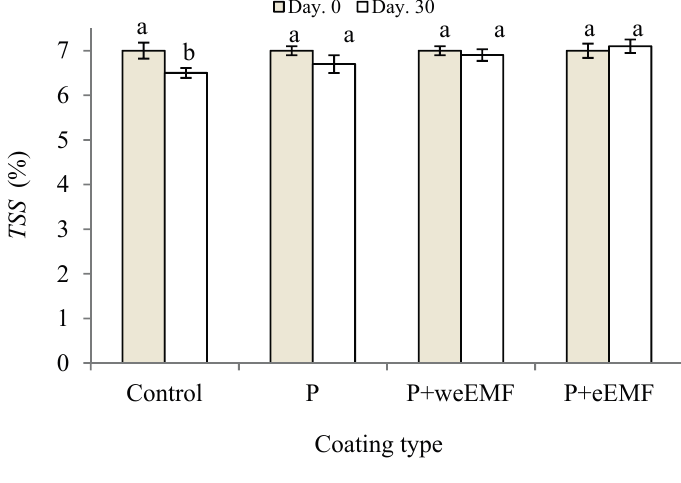
Figure 5. Changes total soluble solids contents (TSS) in uncoated (Control) and coated peppers after 30 days of cold storage at 6 °C. Red sweet peppers coated with pullulan coating (P), pullulan coating containing water-ethanol meadowsweet flower extract (P + weEMF) or pullulan coating containing ethanol meadowsweet flower extract (P + eEMF). Values are mean ± SD. Columns with different letters (a, b) are significantly different according to Tukey’s test ( p < 0.05).